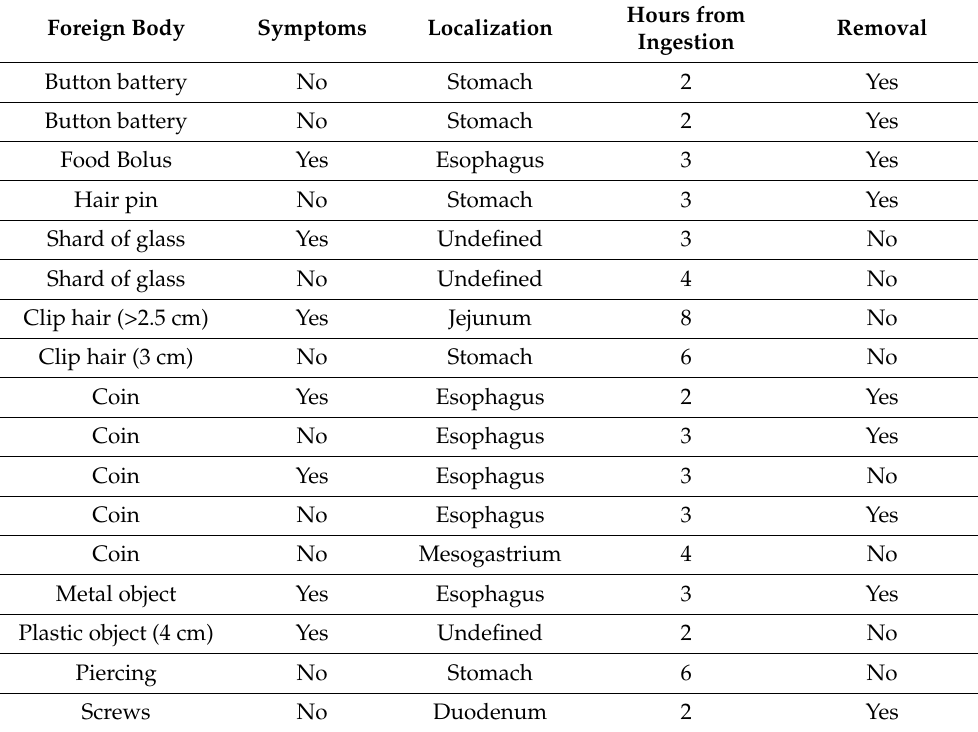
Table 2. Timing and features of endoscopy